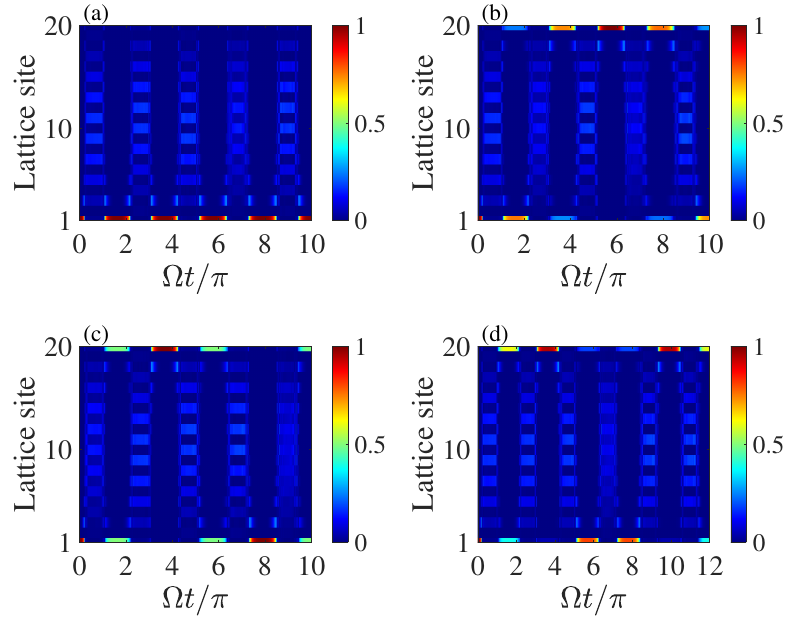
Figure 6. The different TBSs in Figure 5a–d under the long time evolution. The TBS can still be achieved under the long time evolution. The parameters are the same as in Figure